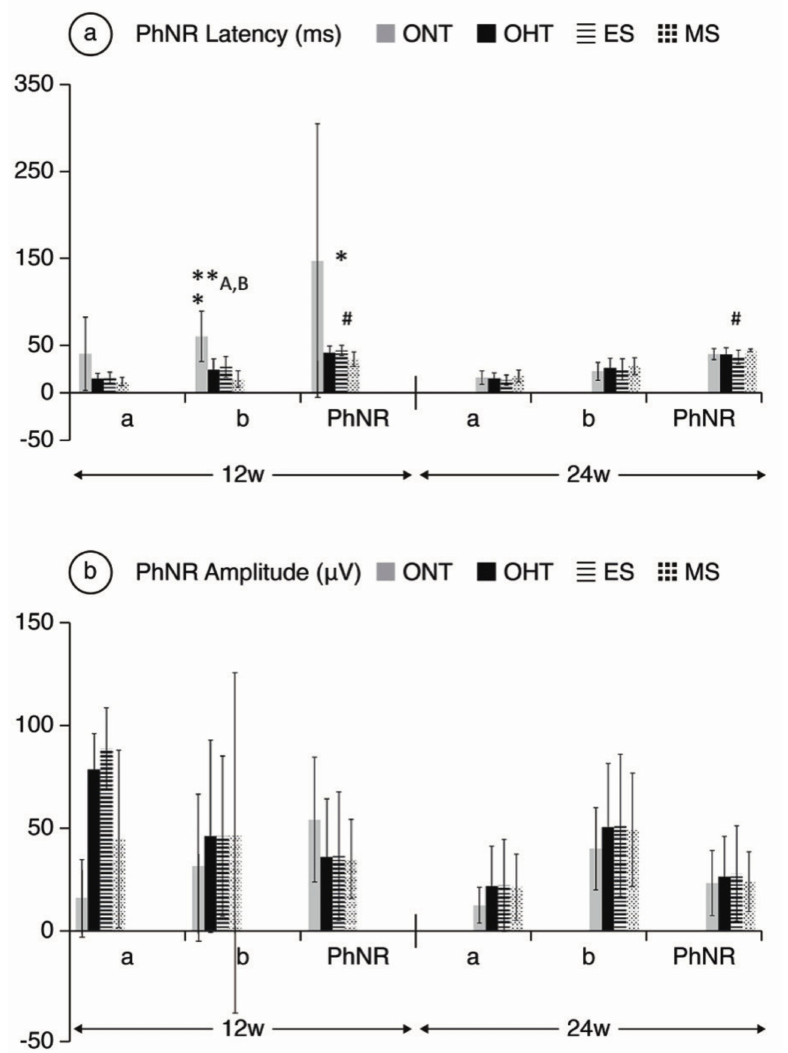
Figure 6. PhNR wave electroretinographic response in both the ocular normotension and ocular hypertension cohorts and the ocular hypertension sub-groups at weeks 12 and 24. ( a ) PhNR latency of in milliseconds under photopic conditions. ( b ) PhRN amplitude in microvolts under photopic conditions. Abbreviations: ONT: ocular normotension group; OHT: ocular hypertension group; ES: episcleral sclerosis group; MS: microspheres group; w: week; ms: milliseconds; µ V: microvolts; * statistical differences between the ONT and OHT cohorts. **: statistical differences between groups (ONT vs. ES vs. MS) (Kruskal–Wallis); #: statistical differences between the ES and MS groups; A: Statistical differences between ONT and ES; B: Statistical differences between ONT and MS. Photopic test: blue background 470 nm, 25 cds/m 2 and red LED flash 625 nm, 0.30 cds/m 2 , 1.199 Hz (20 recordings averaged). a: photoreceptors response; b: intermediate cells response; PhNR: ganglion cells